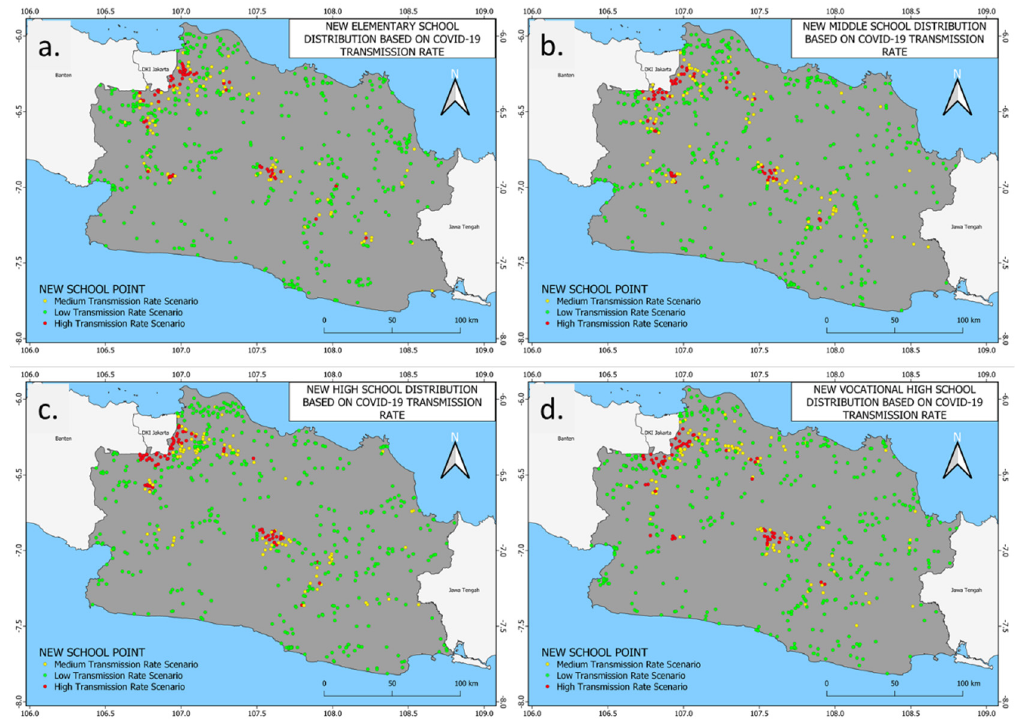
Figure 17. Distribution of new schools by COVID-19 transmission level: ( a ) elementary, ( b ) junior high, ( c ) senior high, and ( d ) vocational high schools.